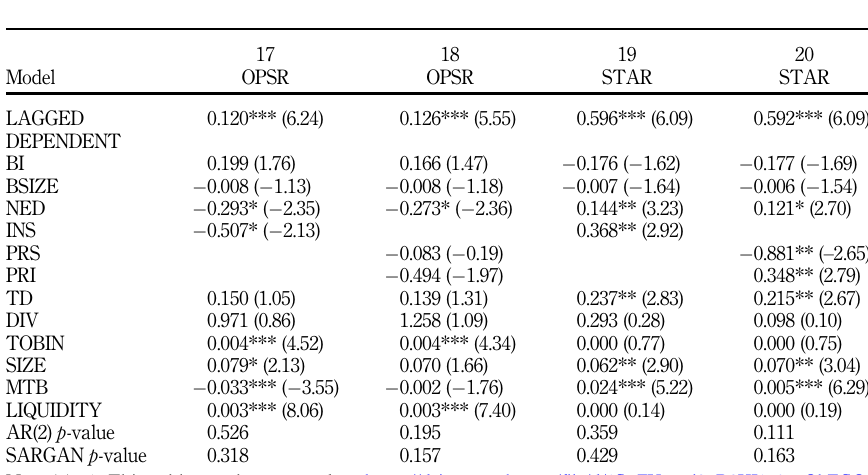
Table 7. Result for low- profit